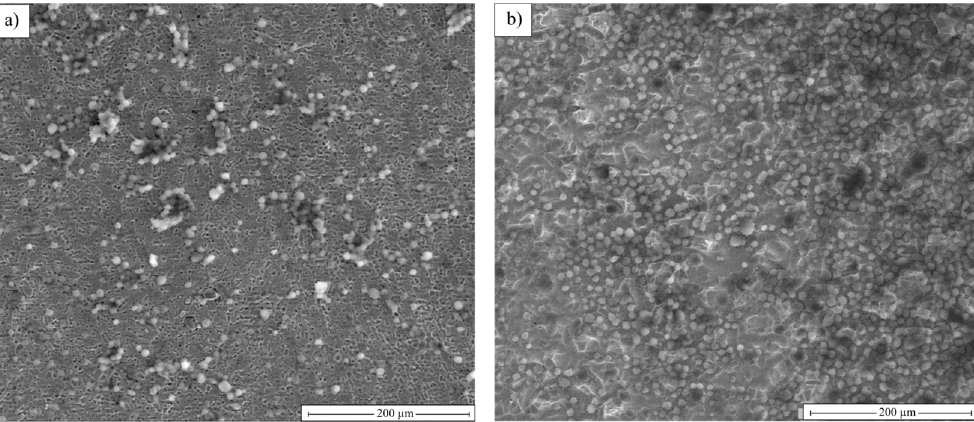
Figure 8. SEM images of hydroxyapatite coatings deposited for ( a ) 2 h and ( b ) 3 h after 72 h culture with MCF-7 cells.